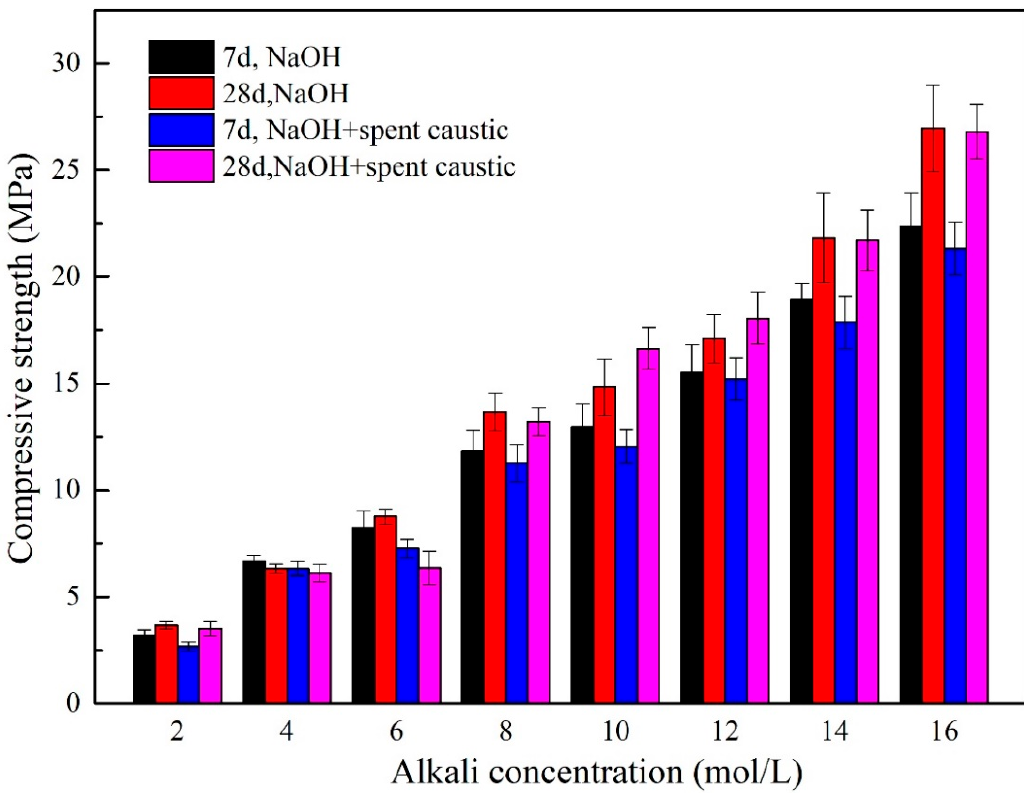
Figure 3. The compressive strength of geopolymers synthesized with different alkali activators.